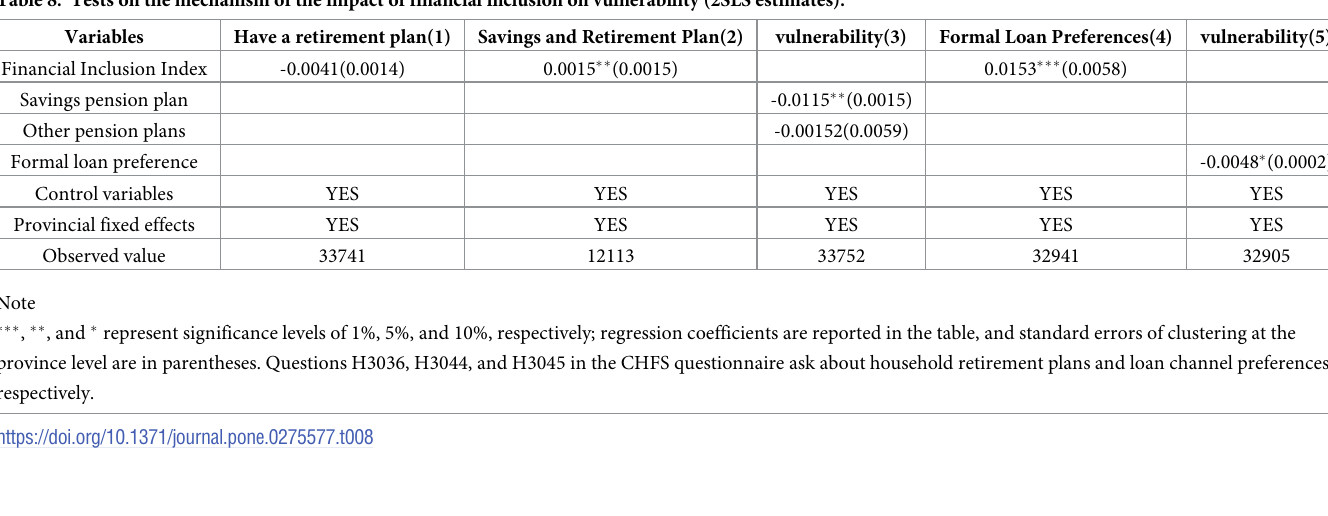
Table 8. Tests on the mechanism of the impact of financial inclusion on vulnerability (2SLS